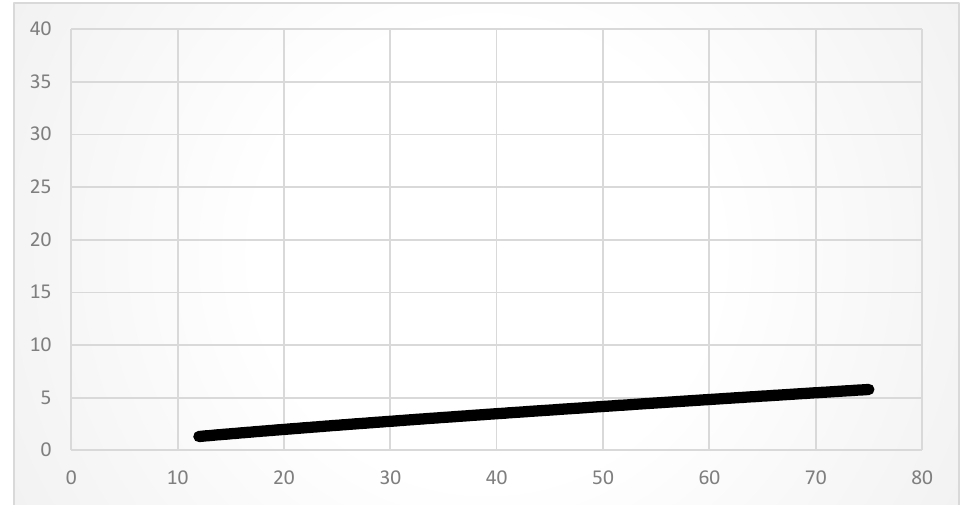
Figure 1. Correlation of ISS ( y -axis) and age ( x -axis) in non-alcoholized patients: the patients’ age is associated with more severe injury patterns.